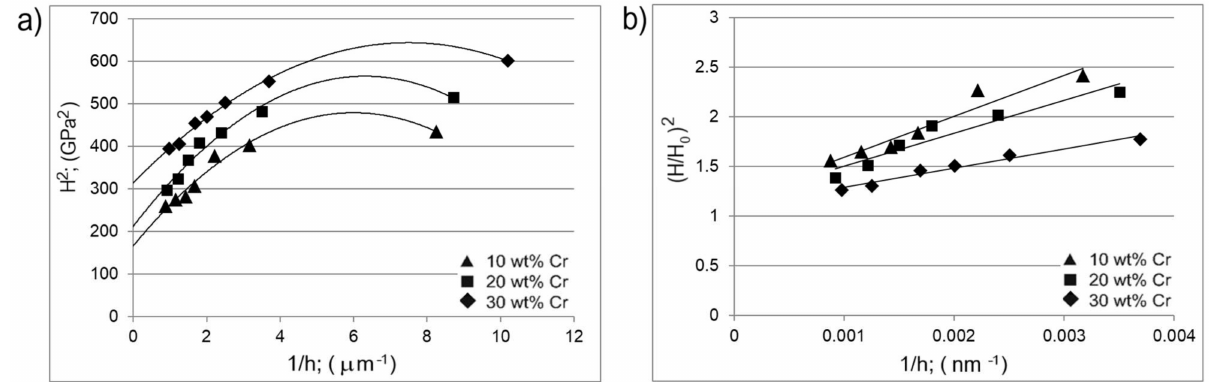
Figure 10. Dependence of the hardness on depth according to the Nix and Gao model: ( a ) the dependence H 2 to 1/h, ( b ) the dependence (H/H 0 ) 2 to 1/h for the tested areas containing 10, 20 and 30 wt.% of